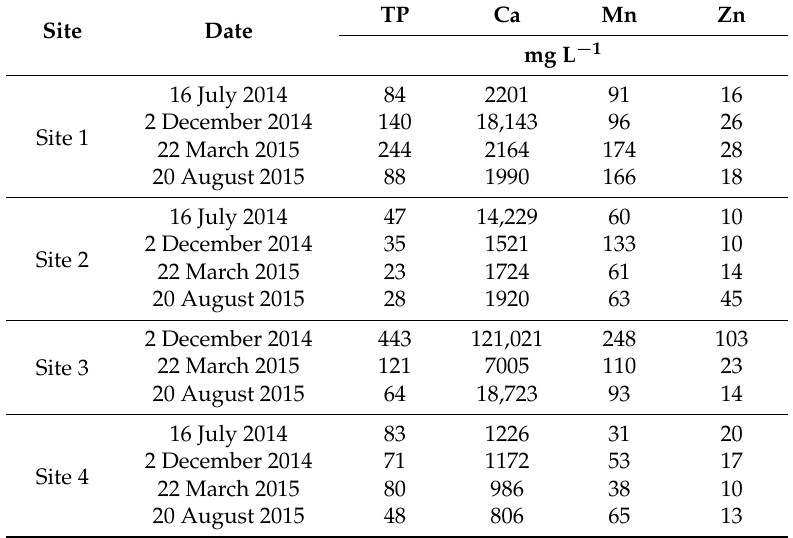
Table A1. Concentration of TP, Ca, Mn, and Zn in sediment samples collected at the Calcasieu